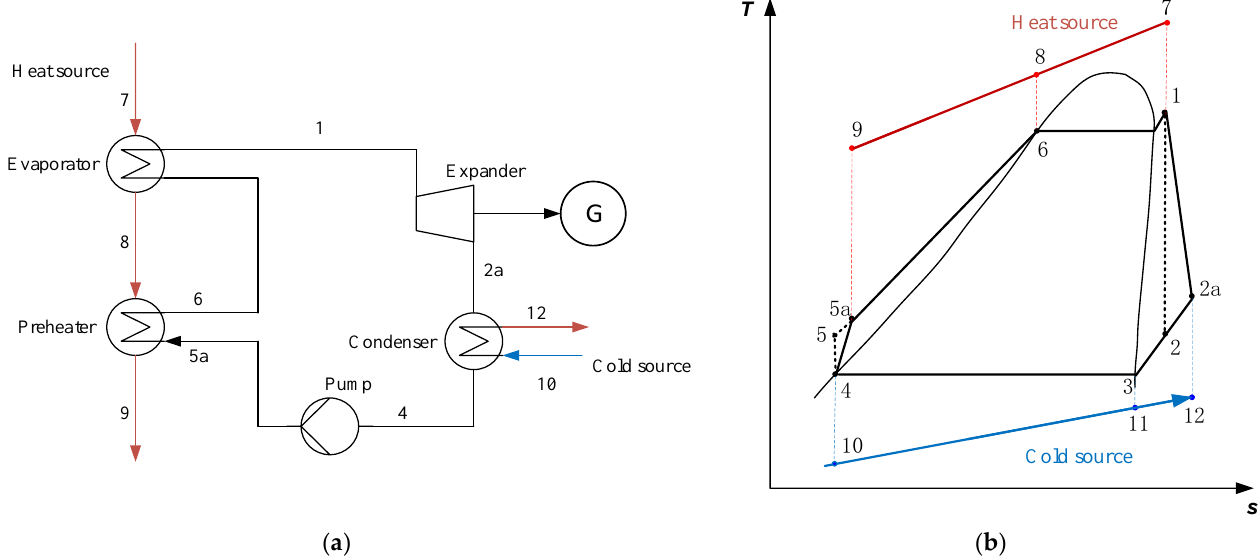
Figure 1. Cycle configuration and cycle T -s diagram of the simple organic Rankine cycle: ( a ) cycle configuration and ( b ) cycle T -s diagram.